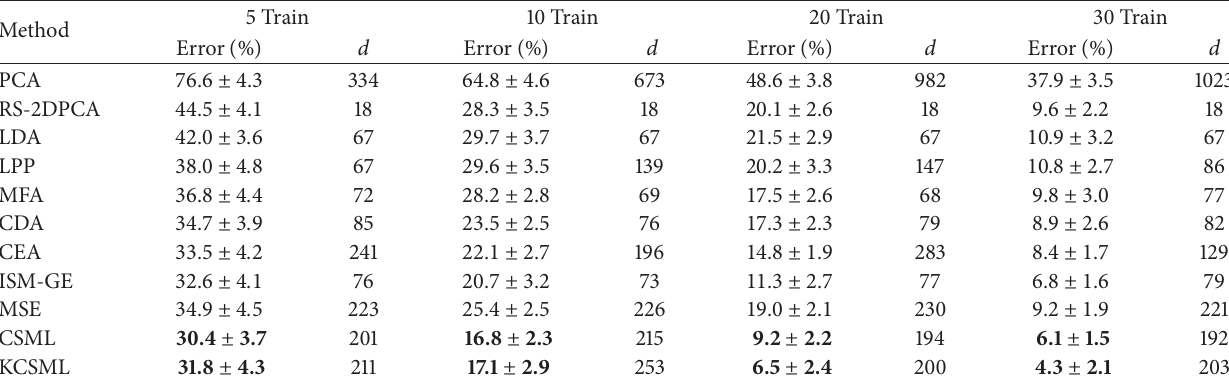
Table 3: Classification performance comparison on the CMU PIE